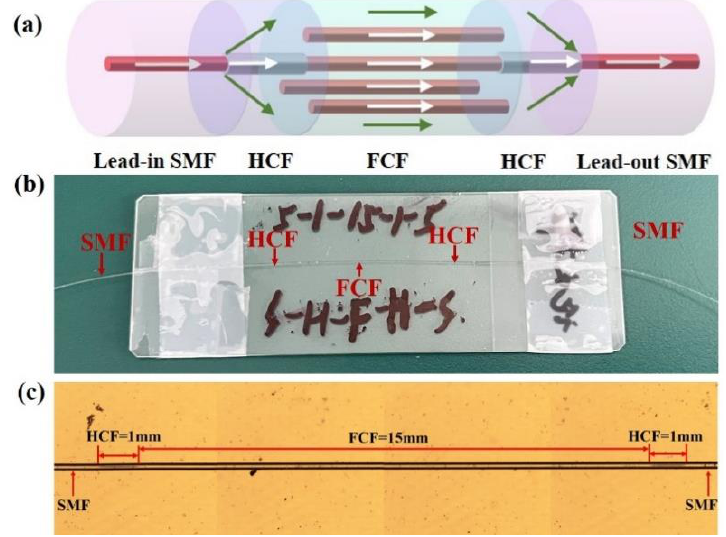
Sensors 2022 , 22 , x FOR PEER REVIEW Figure 2. ( a ) The schematic diagram of the proposed SMF – HCF – FCF – HCF – SMF structure; ( b ) the Figure 2. ( a ) The schematic diagram of the proposed SMF–HCF–FCF–HCF–SMF structure; ( b ) the photo of the actual structure; and ( c ) the photograph under the microscope. photo of the actual structure; and ( c ) the photograph under the microscope.